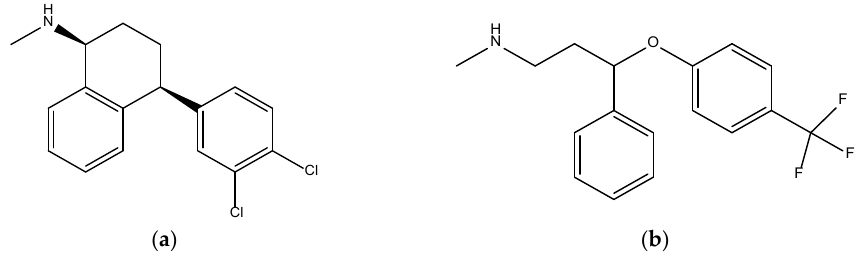
Figure 1. Chemical structures of sertraline ( a ) and fluoxetine ( b ).